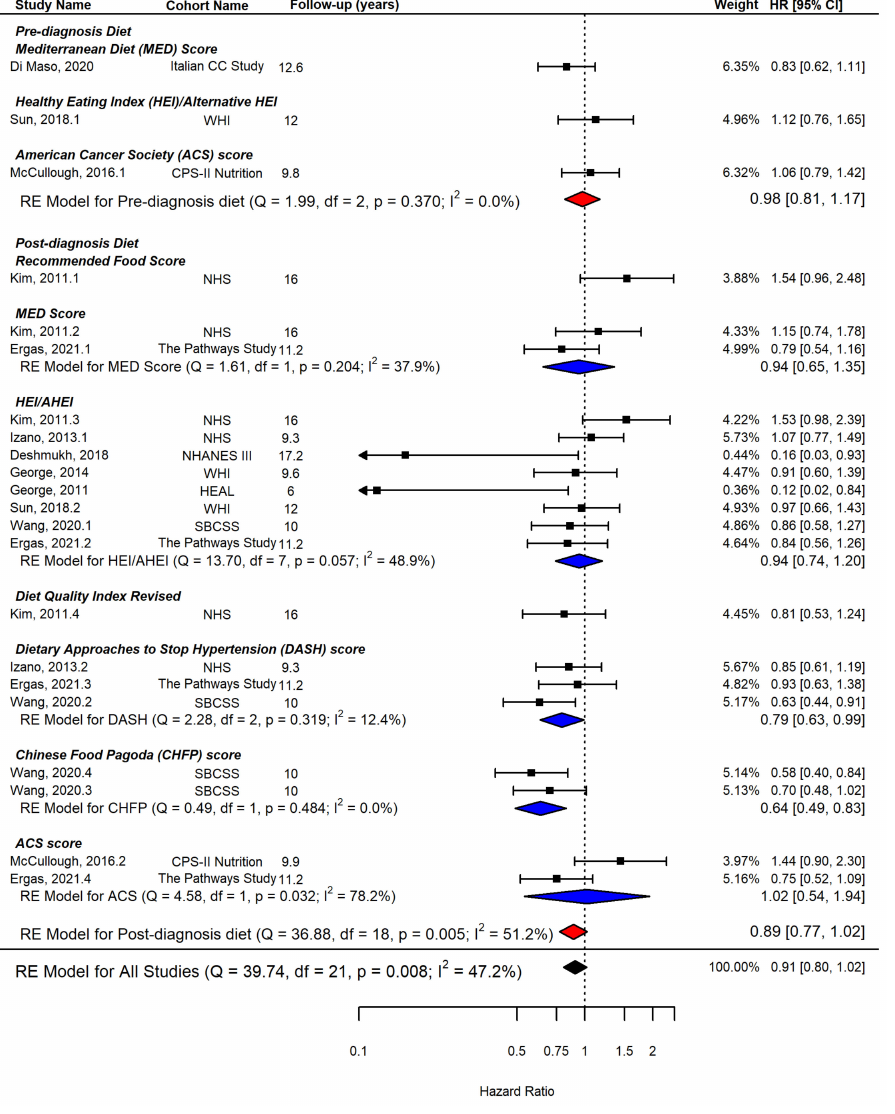
Figure 4. Forest plot showing pooled hazard ratios (HRs) with 95% confidence interval (CI) for association between highest vs. lowest diet quality and risk of breast cancer-specific mortality in